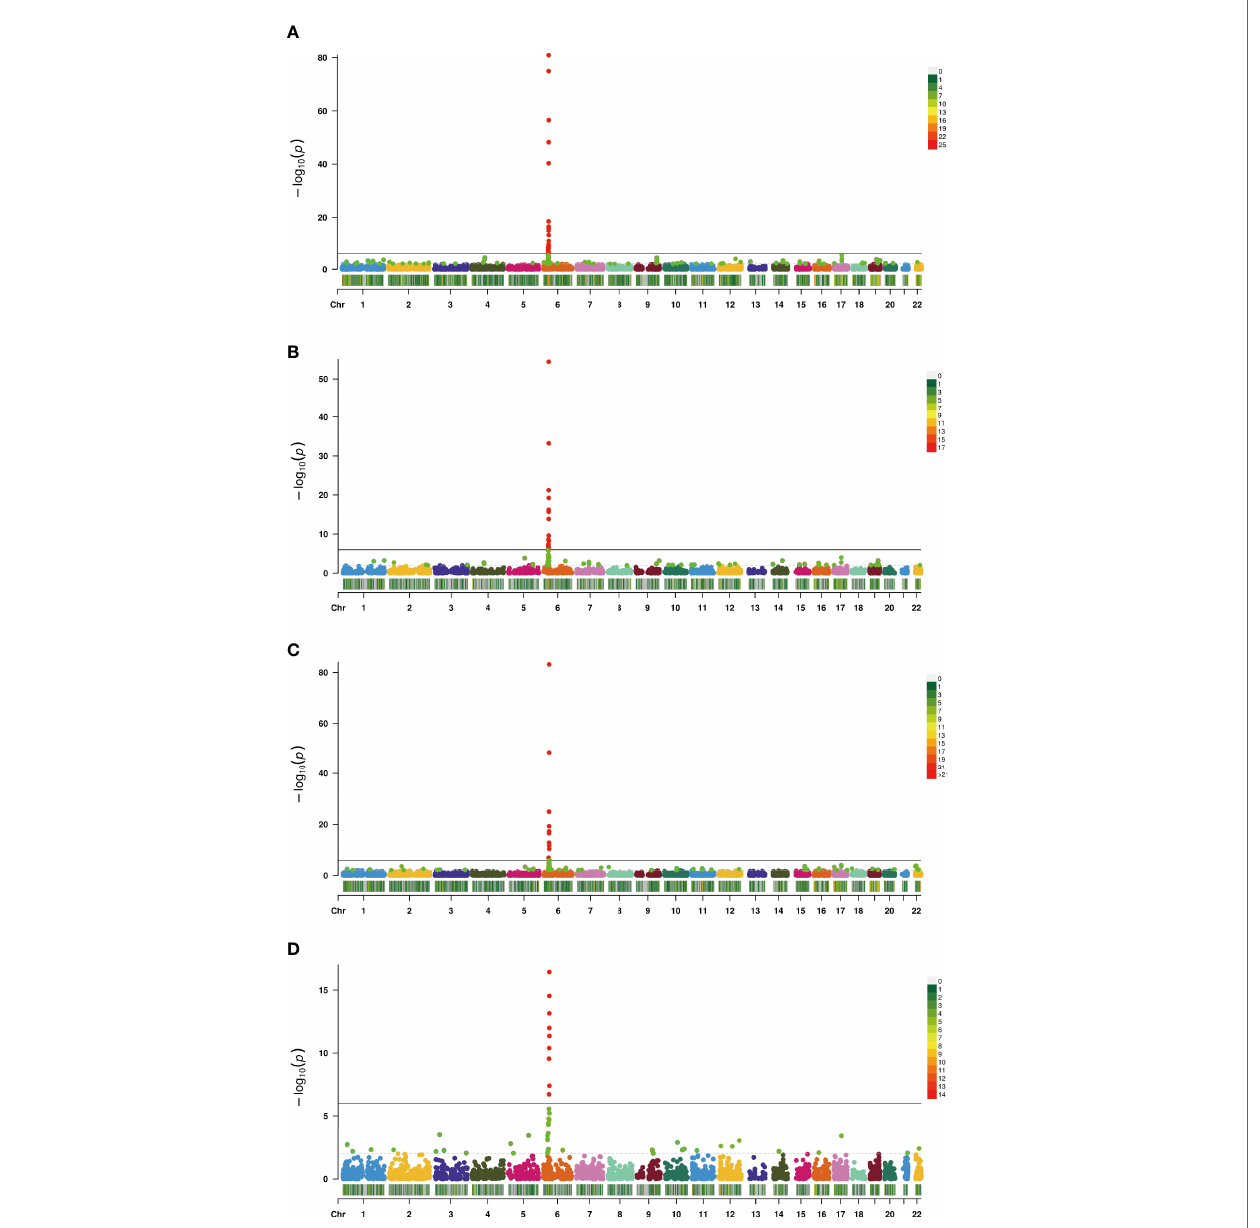
FIGURE 2 | Manhattan plot of AS-associated genes identi fi ed by TWAS (colored dots). Each dot represents a gene, the x-axis is the physical location (chromosomal localization) and the y-axis is the -log10 (p-value) of the gene ’ s association with AS. Signi fi cant genes in different tissues/cells are highlighted in different colors ( A , TF; B , EL; C , YBL; D ,